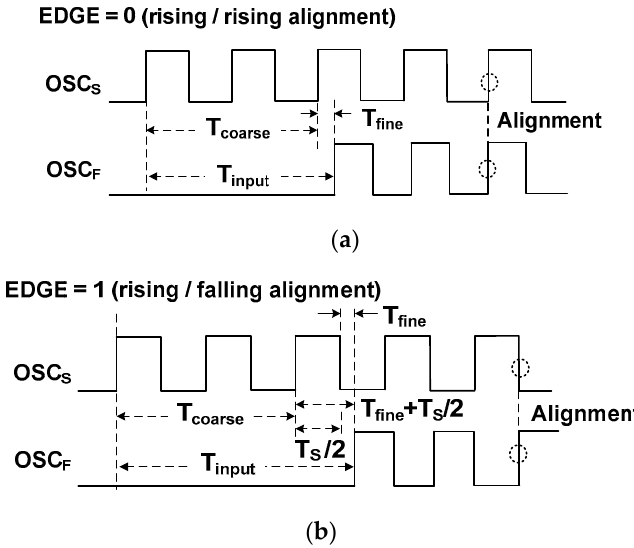
Figure 13. Waveform for two cases of EDGE bit. ( a ) Rising/rising alignment, ( b ) rising/falling alignment.